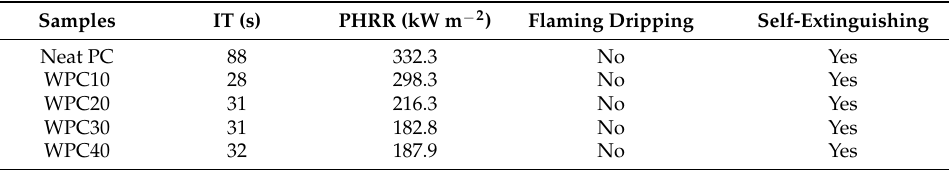
Figure 2. Mass retention curves of wood flour/PC composites ( a ) and the mass residue of the resulting composites at 500 s ( b ). Table 2. Combustion parameters of wood flour/PC composites.